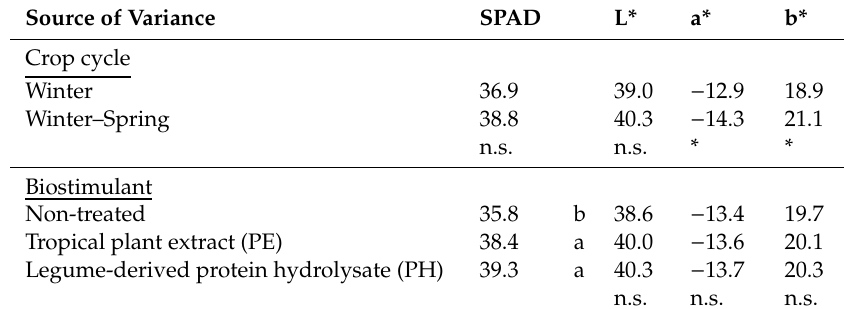
Table 2. Mean values of SPAD (Soil Plant Analysis Development) index and colour components of perennial wall rocket as a ff ected by crop cycle and biostimulant. Source of Variance SPAD L* a* b* Crop cycle Winter 36.9 Winter–Spring 38.8 Biostimulant Non-treated Legume-derived protein hydrolysate